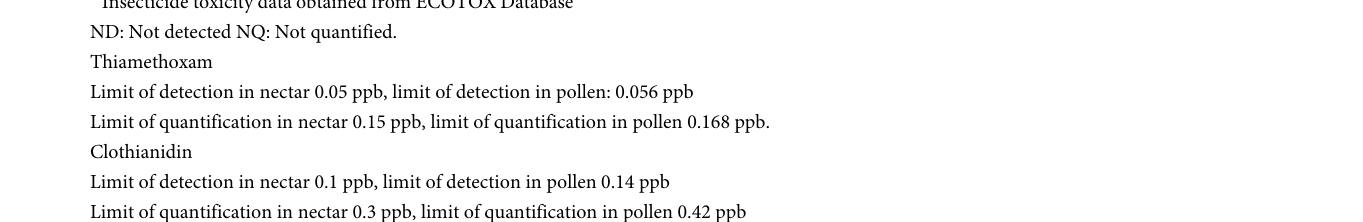
S1 Fig. Relation between the number of bee visits per plot and percentage defoliation on fruit number and fruit weight in squash plants.